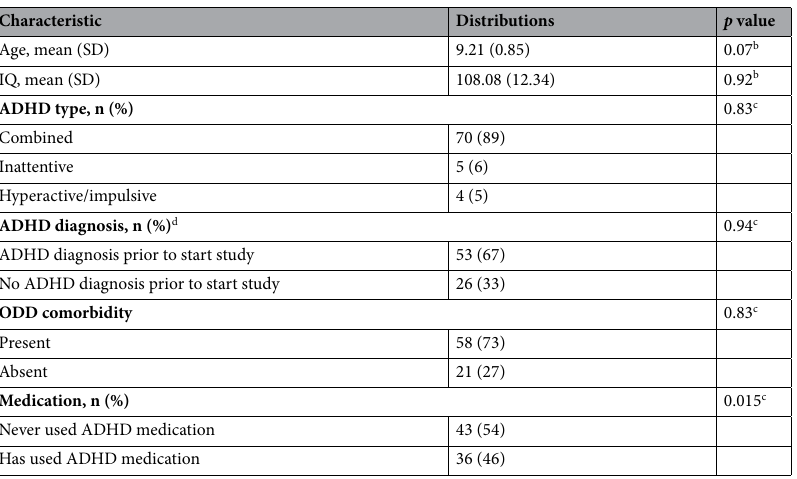
Table 1. Baseline characteristics of all participants (n = 79) a at t1 and their significance with ARS score decrease (%). ADHD attention-deficit hyperactivity disorder, ARS attention-deficit hyperactivity disorder (ADHD) rating scale, FFD few-foods diet, ODD oppositional defiant disorder, IQ intelligence quotient, SD standard deviation, t1 before start FFD. a Also for the subgroups included in the fMRI analyses (n = 53 for the stop-signal task and n = 32 for the Flanker task), p-values indicated no significant association between baseline characteristics at t1 and ARS score decrease (%) after correction for multiple-testing. b Spearman rank test. c Kruskal-Wallis test. d All boys, aged 8–10 and meeting the DSM-IV ADHD criteria were eligible for participation, also if they had not officially been diagnosed with ADHD prior to the study start.